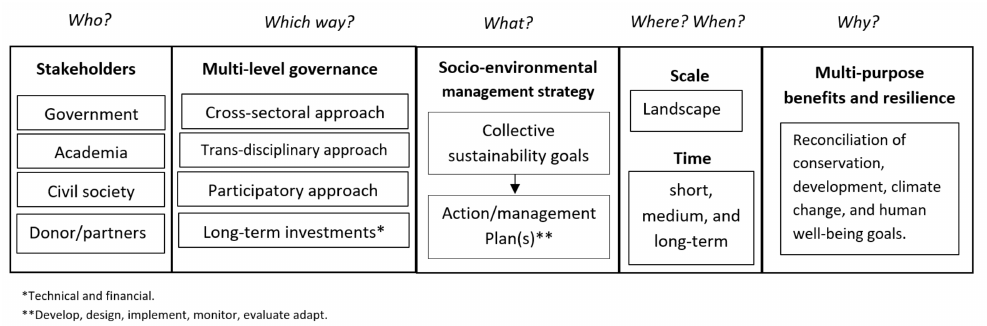
Figure 5. The Six W’s of the ILA (Source: own elaboration by